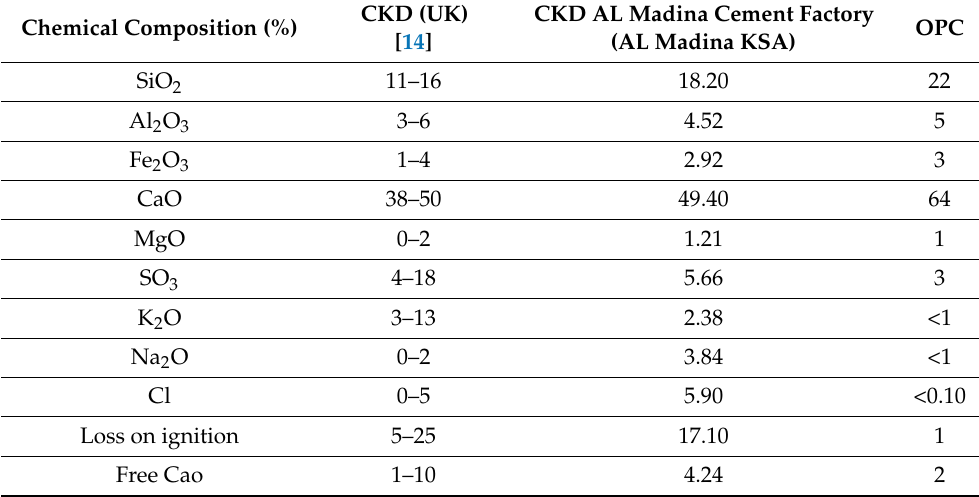
Table 2. Typical chemical compositions of CKD and ordinary portland cement (OPC) in the UK and